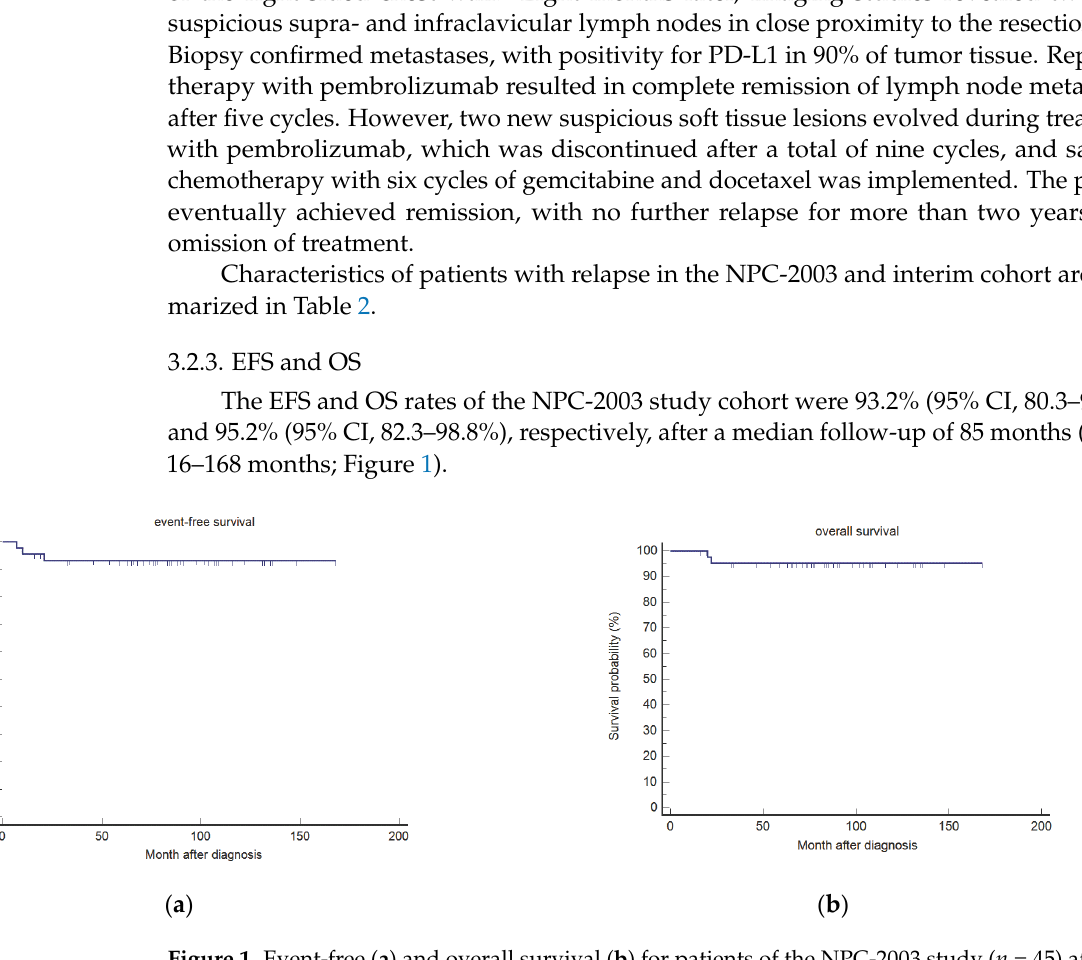
Figure 2. Event-free and overall survival for all patients of the NPC-2003 study and the interim phase ( n = 66) after a median follow-up of 73 months, and for the interim patients alone ( n = 21) after a median follow-up of 40 months.